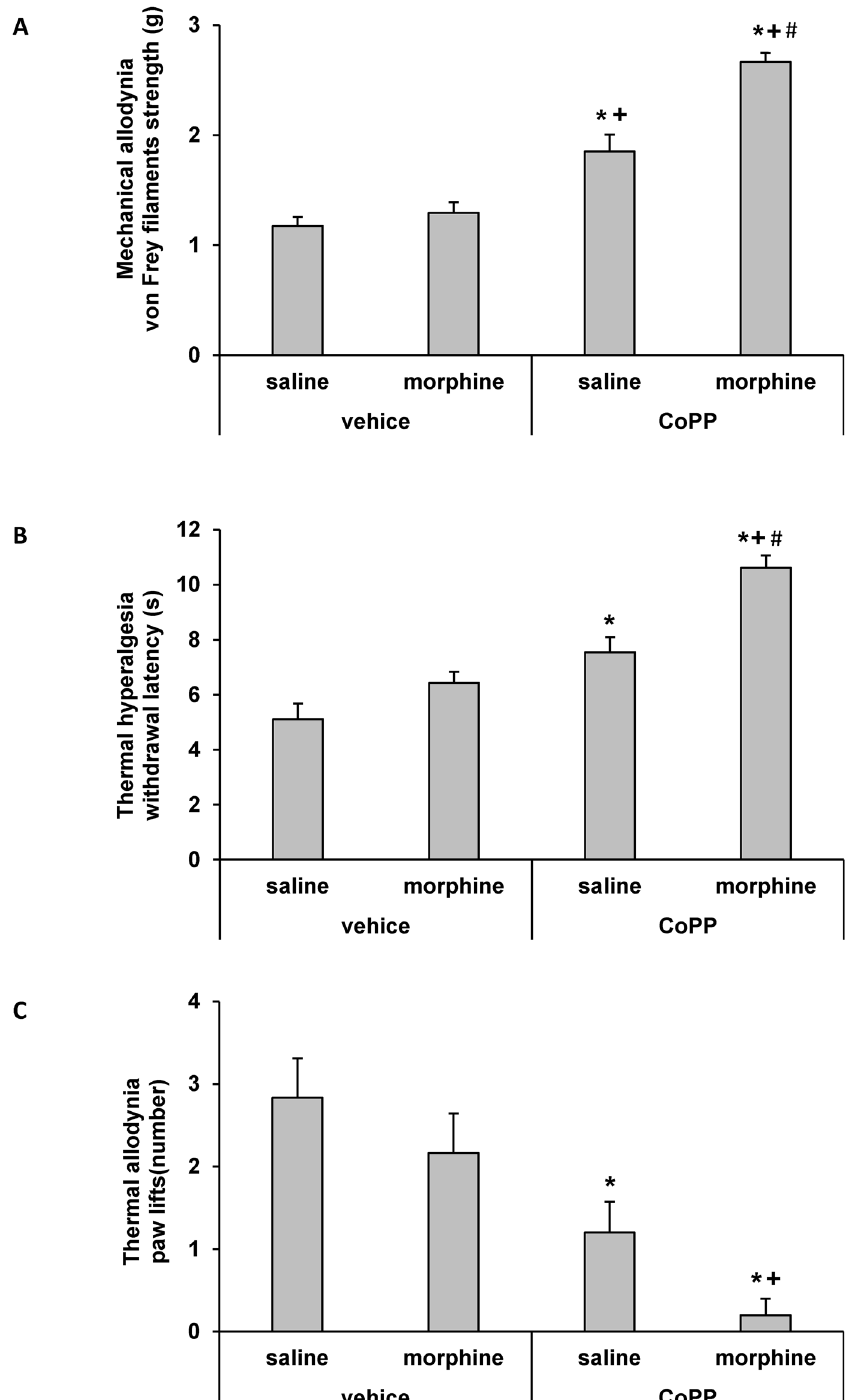
Fig 3. Effects of CoPP treatment on the antiallodynic and antihyperalgesic responses to morphine. Mechanical antiallodynic (A), thermal antihyperalgesic (B), and thermal antiallodynic (C) effects of the subcutaneous administration of 0.5 mg/kg of morphine or saline in STZ-injected mice pretreated with vehicle (DMSO 1%) or 10 mg/kg of CoPP. The effects of the intraperitoneal administration of CoPP alone are also shown. Data are expressed as von Frey filaments strength (g) for mechanical allodynia, withdrawal latency (s) for thermal hyperalgesia and paw lifts (number) for thermal allodynia. For each behavioral test, * denotes